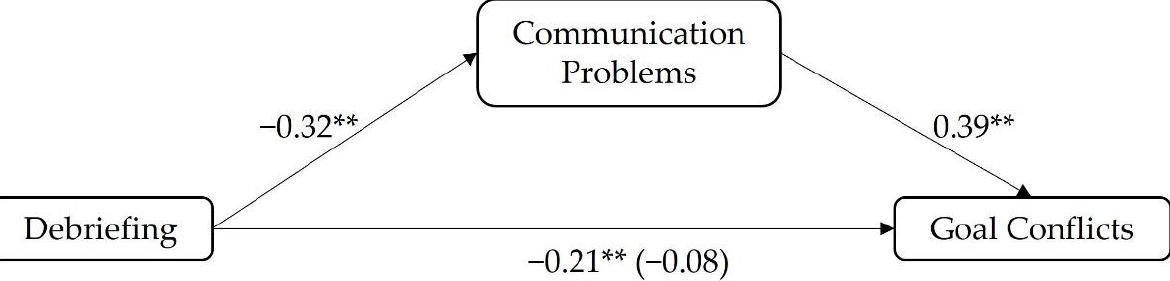
Figure 2. Results of Hypothesis 2a: * p < 0.05; ** p < 0.001.